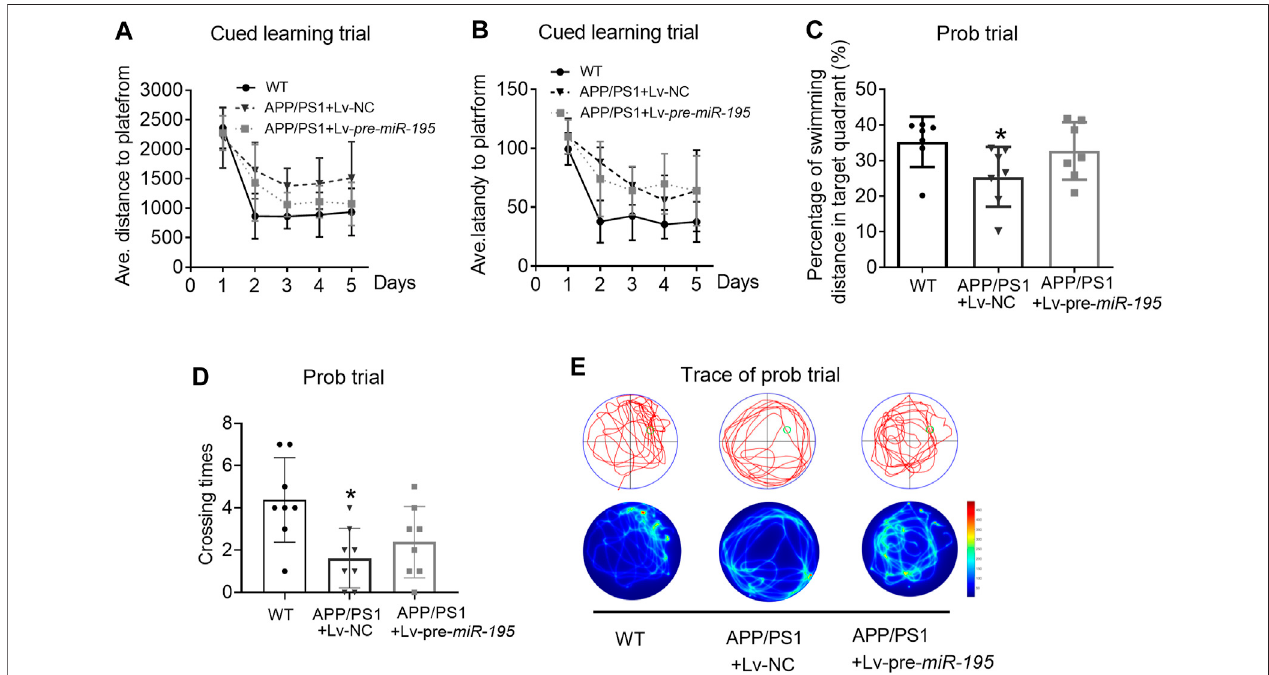
FIGURE 4 | MiR-195 attenuates the declined learning ability butnot affects the impaired memory function in APP/PS1 mice after brain injection of Lv-pre- miR-195 for 2M (A) Average distance to platform after brain injection of Lv-pre- miR-195 for 2M. n (cid:2) 8 for WT, Lv-NC and Lv-pre -miR-195 group (B) Average escape latency to platform after treatment of Lv-pre -miR-195 for 2M. n (cid:2) 8 for WT, Lv-NC and Lv-pre -miR-195 group (C) Percentage of swimming distance in the target quadrant relative to the total distance of the pool during probe trial. * p < 0.05 vs. WT, n (cid:2) 8 (D) Number of times to cross the target platform during probe trial. * p < 0.05 vs. WT, n (cid:2) 8 (E) Representative path tracings and heat maps of the probe test on day 6 in the MWM test for each group.